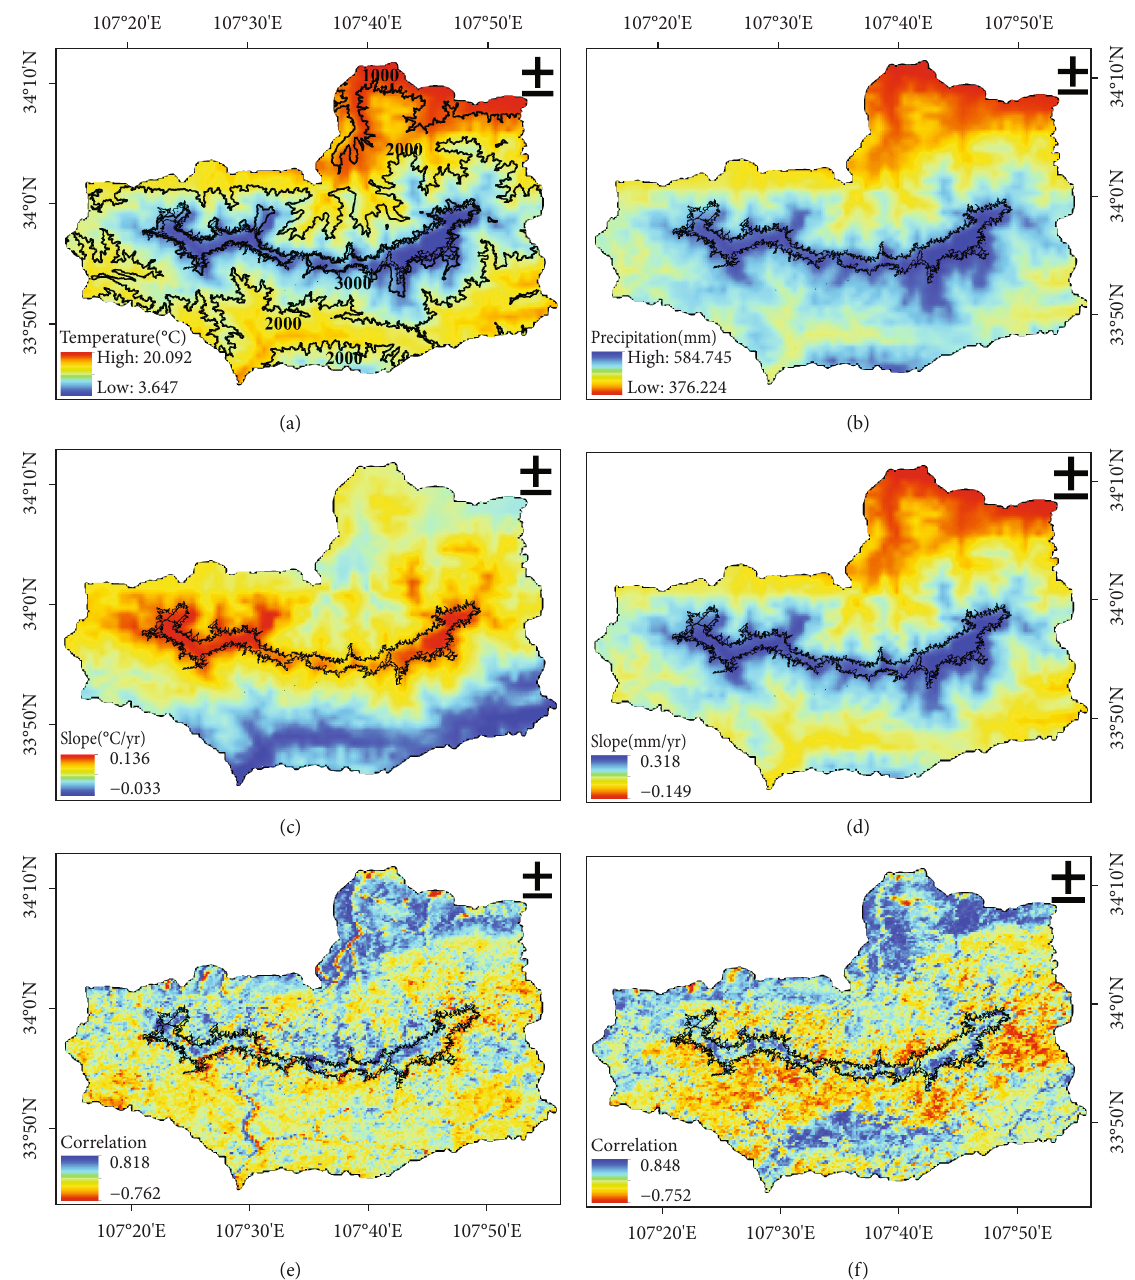
Figure 8: Spatial distribution of the meteorological factors and their correlation with the NDVI during the growing season: (a) mean annual temperature, (b) mean precipitation, (c) temperature change trend, (d) precipitation change trend, (e) correlation between temperature and the vegetation NDVI, and (f) correlation between precipitation and the vegetation